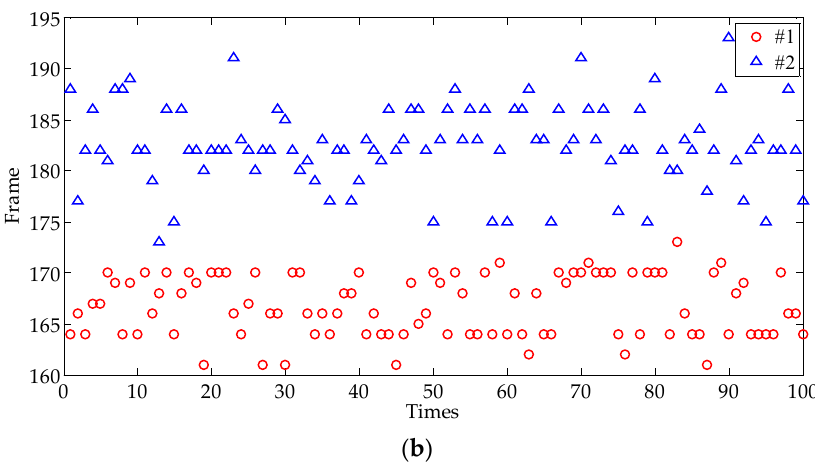
Figure 24. The scatter diagram of the experiment conducted 100 times to be compared with Figure 19: ( a ) The scatter diagram of the experiment conducted 100 times by uniform selection; ( b ) The scatter diagram of the experiment conducted 100 times by random selection.